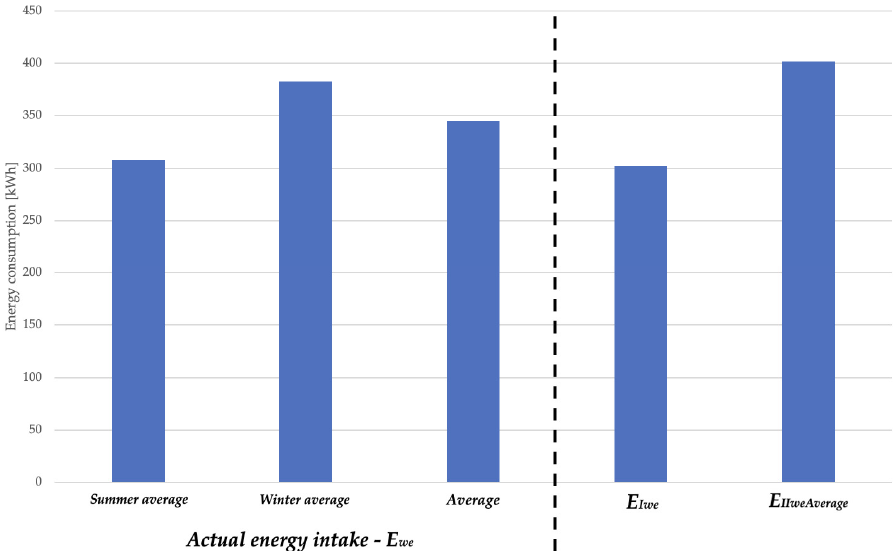
Figure 6. Comparison of electricity consumption based on the actual railway track construction, where vertical dashed line—exposure: real traction electricity consumption in correlation with the seasons (left side) in relation to Variant I and II (right side).